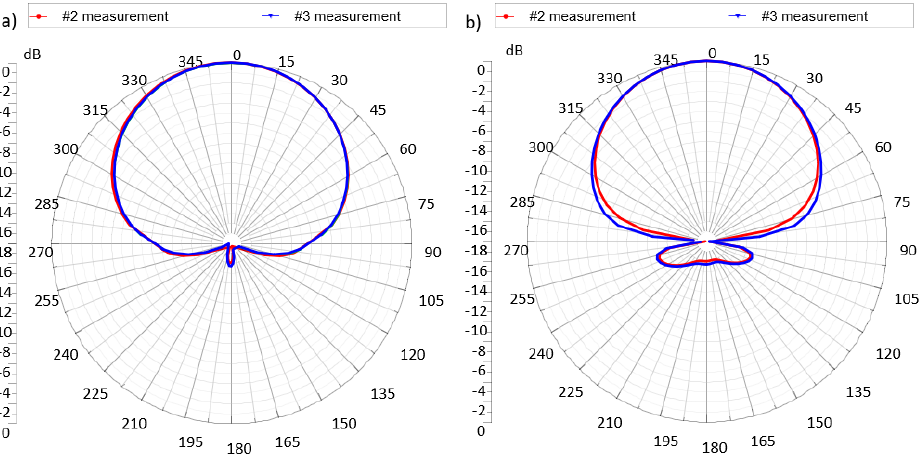
Figure 7. Preliminary tests of the radiation patterns.